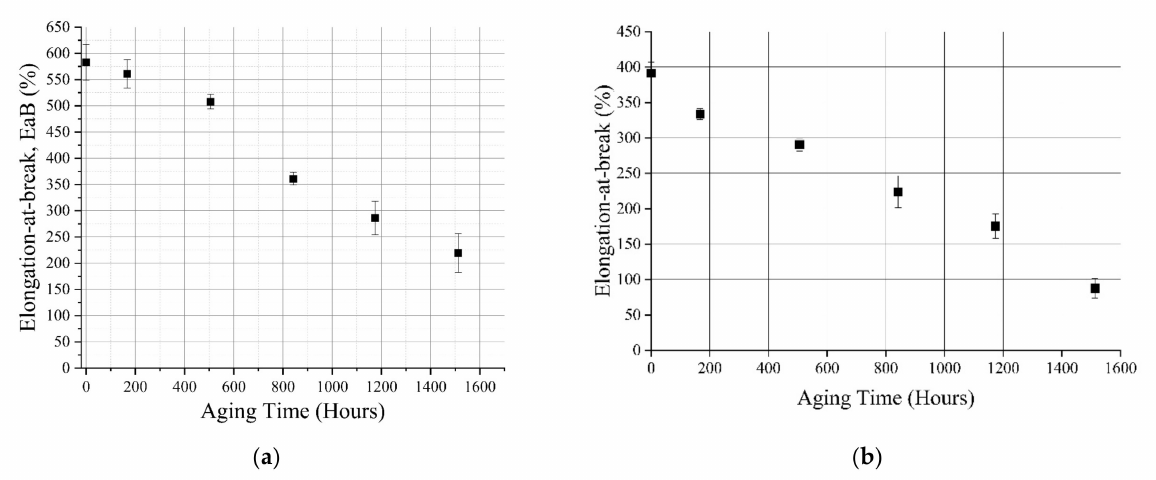
Figure 8. Elongation at break against different thermal aging periods ( a ) EPR insulation and ( b ) CSPE